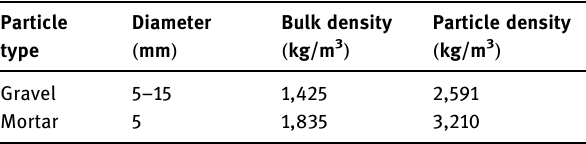
Table 2: Density of gravel and